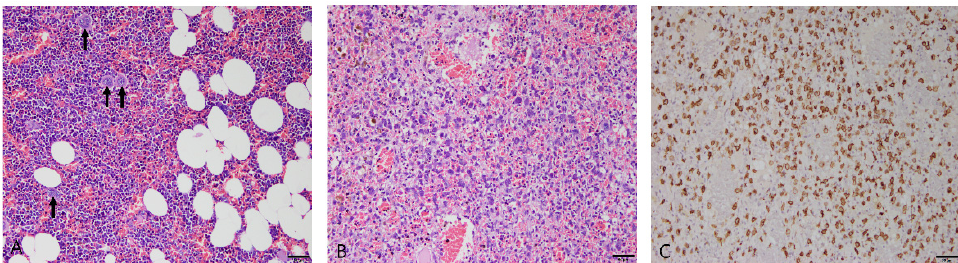
Figure 6. ( A ) Myelolipoma in the spleen of a dog. Immature hematopoietic cells were intermixed with well-differentiated adipocytes. Megakaryocytes were observed (arrows). Hematoxylin and eosin (H&E) at 200× magnification. Scale bar = 50 µm. ( B , C ) Splenic mast cell tumor in the spleen of a dog. ( B ) Mast cells with basophilic cytoplasmic granules proliferated in the splenic parenchyma. H&E at 200× magnification. Scale bar = 50 µm. ( C ) Immunohistochemistry staining for C-kit with Mayer’s hematoxylin counterstain. The neoplastic mast cells showed strong cytoplasmic immunoreactivity with C-kit. 200× magnification. Scale bar = 50 µm.